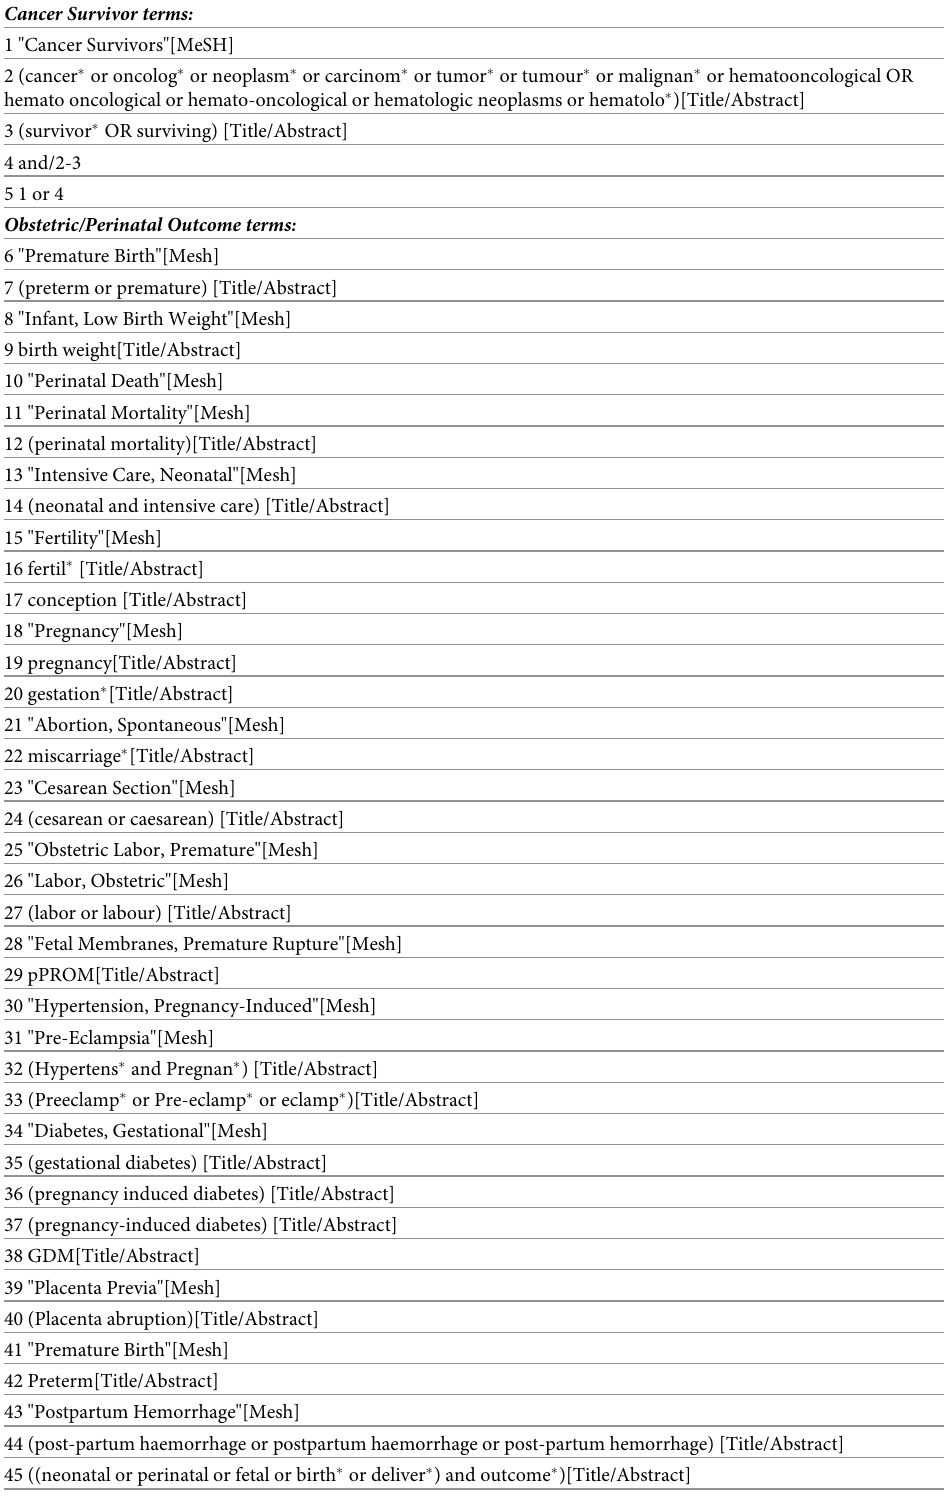
Table 1. Search strategy for pubmed